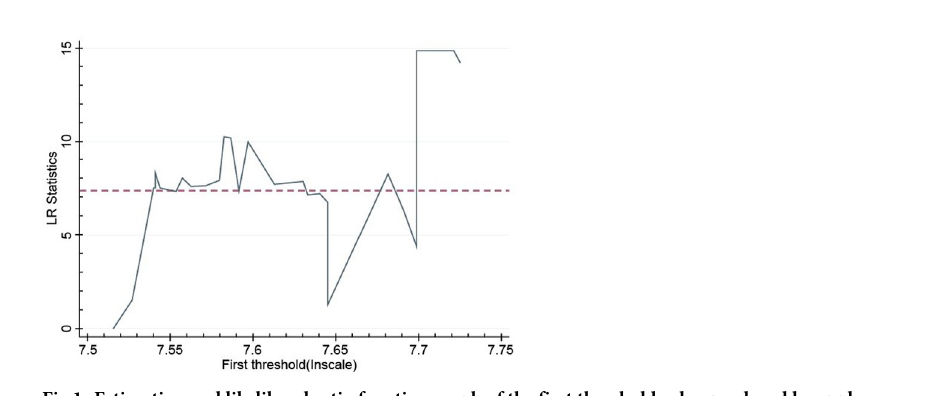
Fig 1. Estimation and likelihood ratio function graph of the first threshold value produced by apple.